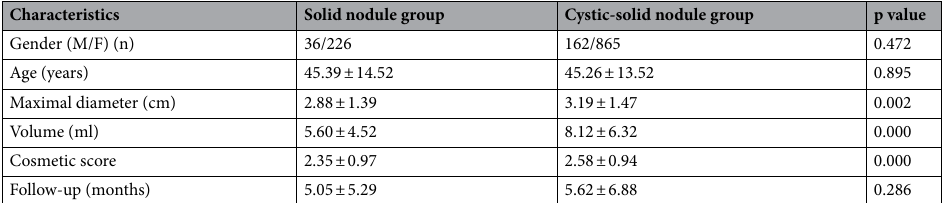
Table 1. Clinical features of solid nodule group and cystic-solid nodule group patients. Means ± SD are shown. p < 0.05 was considered to indicate statistically significant difference. M/F male/female, cm centimeter, ml